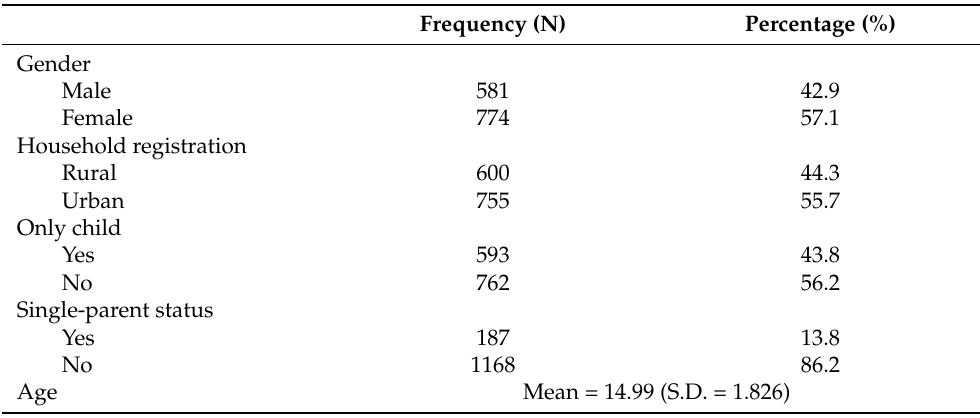
Table 1. Descriptive statistics of socio–demographic characteristics (N = 1355).